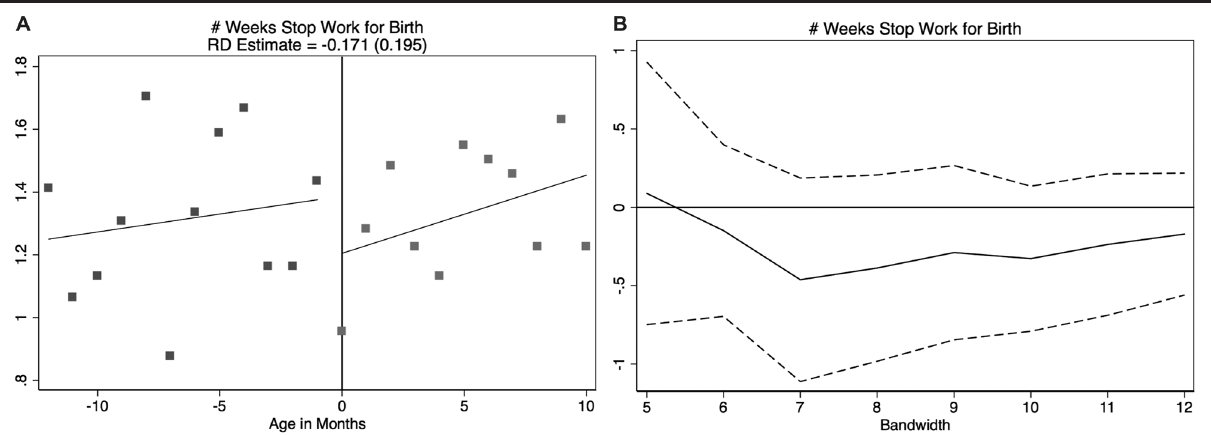
Figure 8 Average number of weeks the mother stopped work before the birth of her child. (A) Each data point corresponds to the average value of each outcome by month of birth of the child in 1-month bins. The window includes all children born to mothers from January 2010 until November 2011. The vertical line denotes the PPL cutoff of January 1 2011, normalized to 0. (B) The equivalent coefficient estimates and associated 95% confidence intervals when equation 1 is estimated using 3, 4, ..., 12 month-of-birth cohorts on either side of the